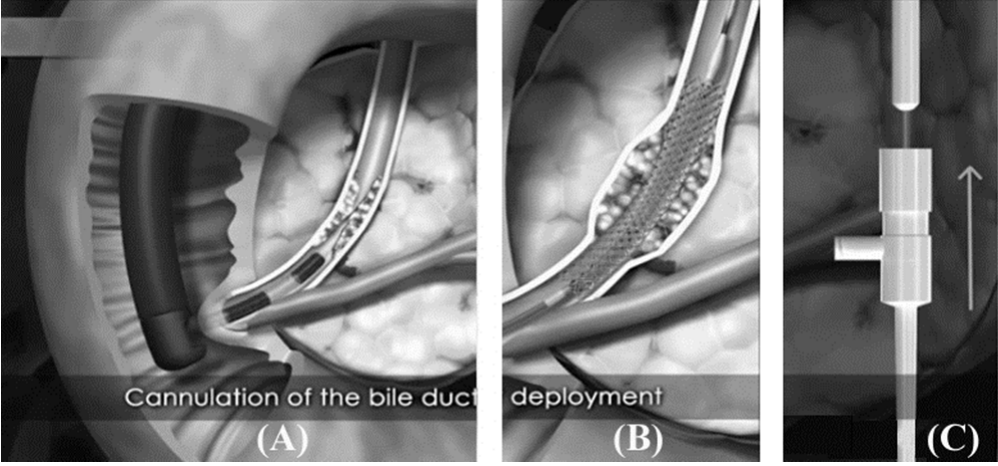
Figure 3. Endoscopic biliary stent placement. The tip of the endoscope is placed at the duodenal pappila, and the delivery catheter containing the compressed stent is pushed across the stricture ( A ); The self expandable nitinol stent comes out of the catheter and expands over several days to reopen the obstructed biliary tract ( B ); To expose the compressed stent inside the catheter, the catheter is pulled back while maintaining the position of the stent with the help of the pusher ( C ). (Courtesy of S&G Biotech, Seongnam,